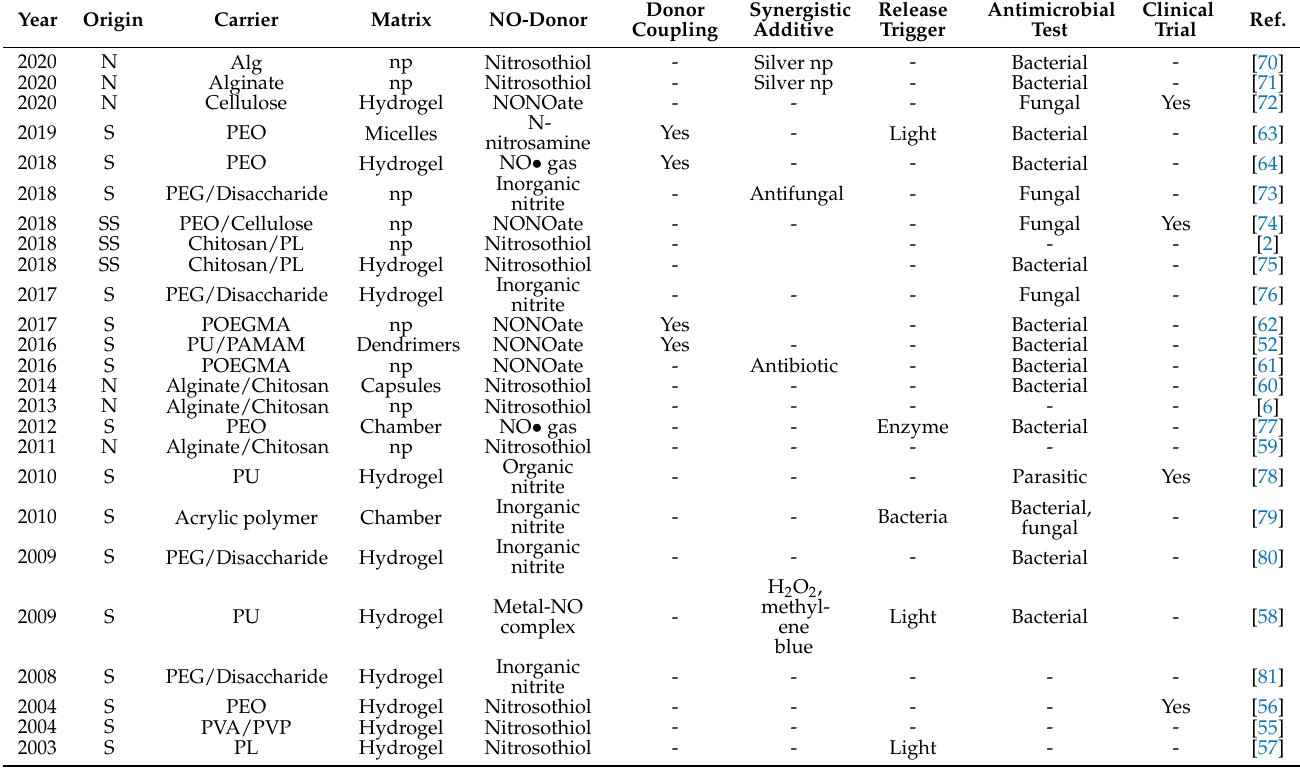
Compilation of publications showing the evolution of NO-donor polymeric carriers intended to treat dermal